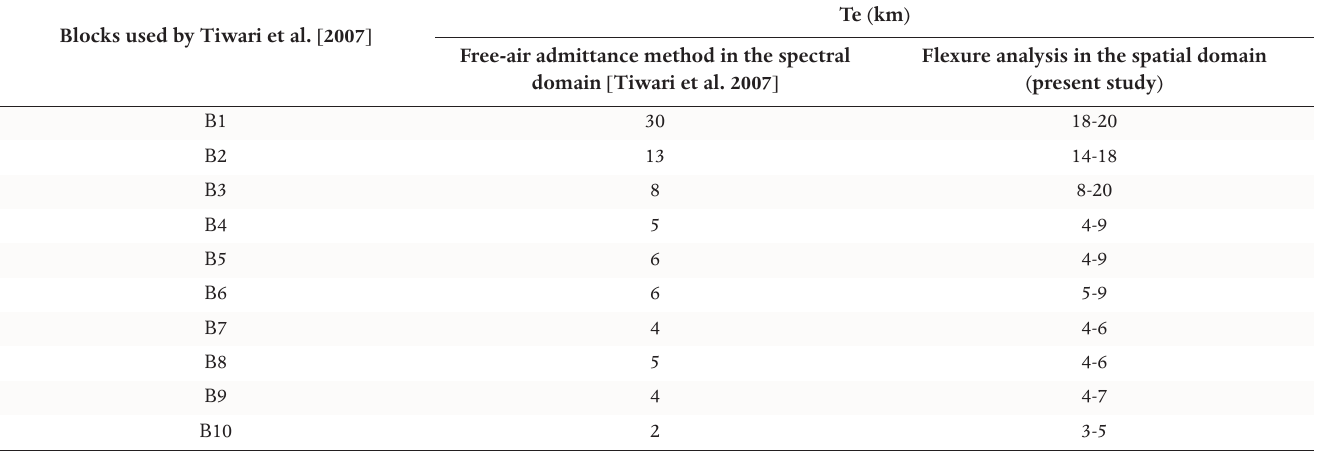
Table 2. Comparisons between the estimated Te values in the spectral and spatial